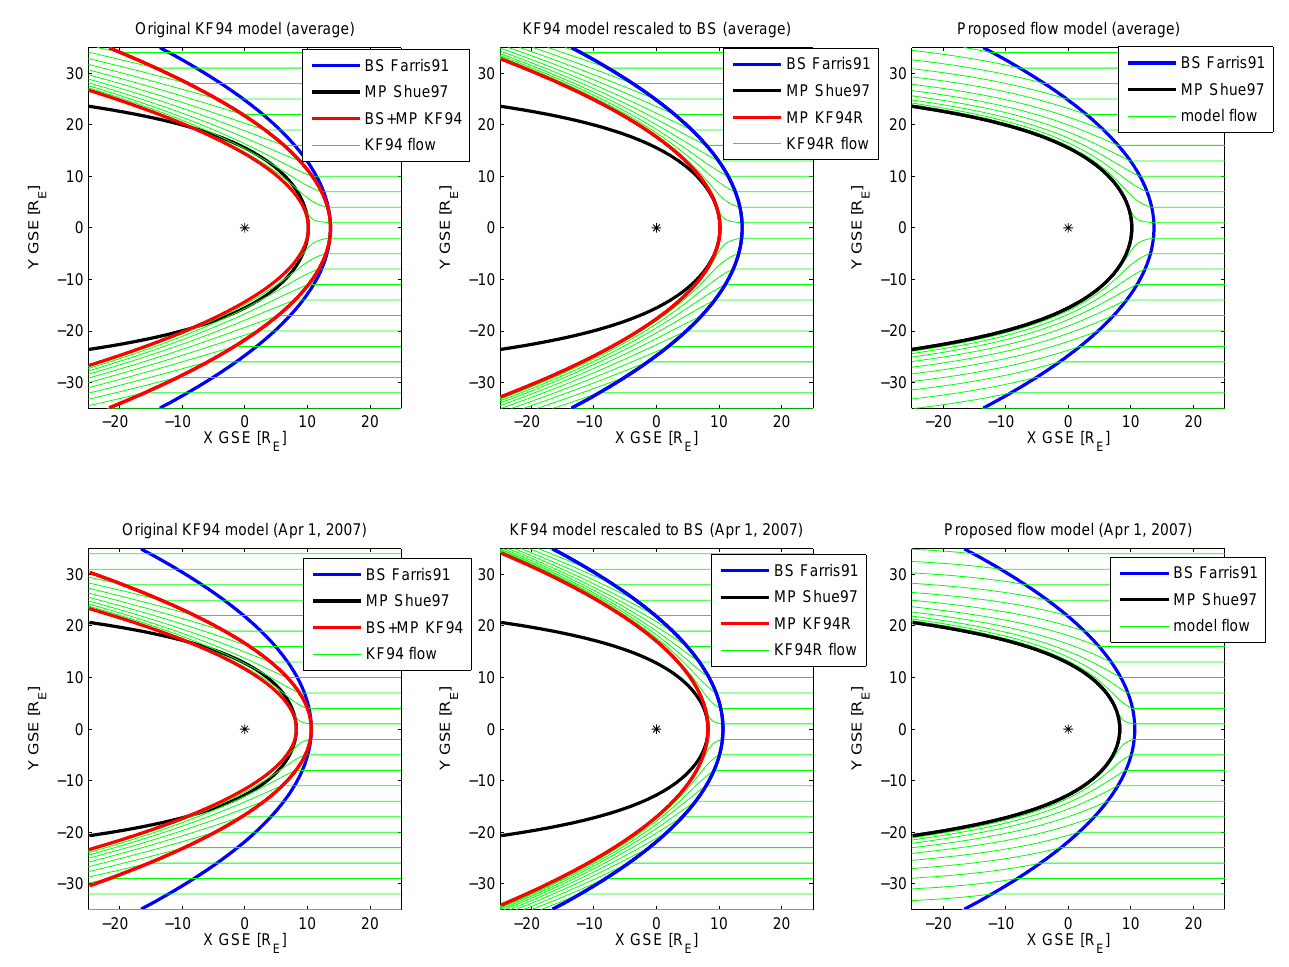
Fig. 2. Comparison of flowlines and boundaries of the model magnetosheath (red line) for the original KF94 model (left), the KF94R model rescaled to fit a general paraboloid bow shock (center) and the final fully rescaled model (right). Superimposed is the Farris et al. (1991) bow shock model (blue) and Shue et al. (1997) magnetopause (black). The top three panels show the comparison for average solar wind parameters, the bottom plots for a set of solar wind parameters from 1 April 2007, 00:00UT.